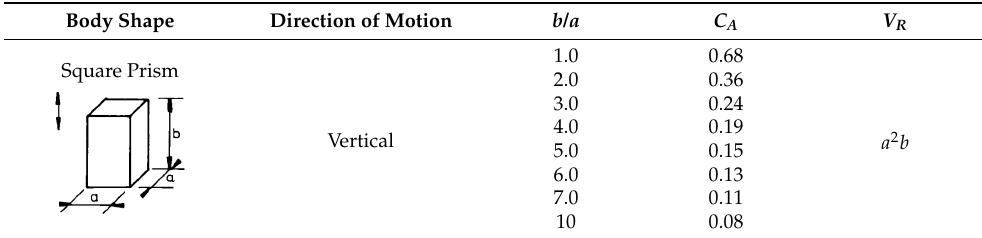
Table A2. Added mass coefficients for the flow parallel to the square prism (reproduced from [48], with permission from DNV, 2021).